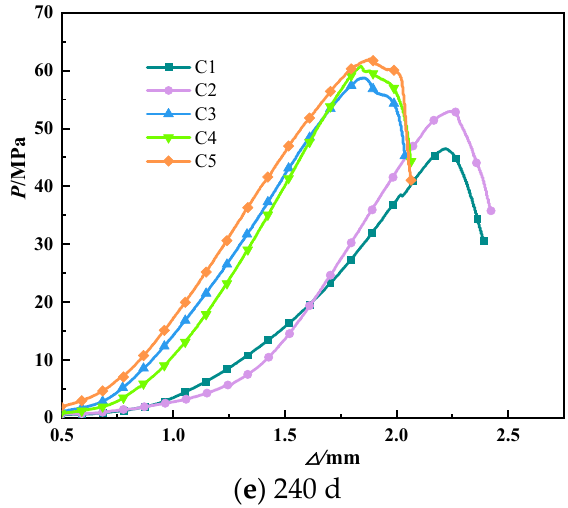
Figure 8. Load-displacement curve.